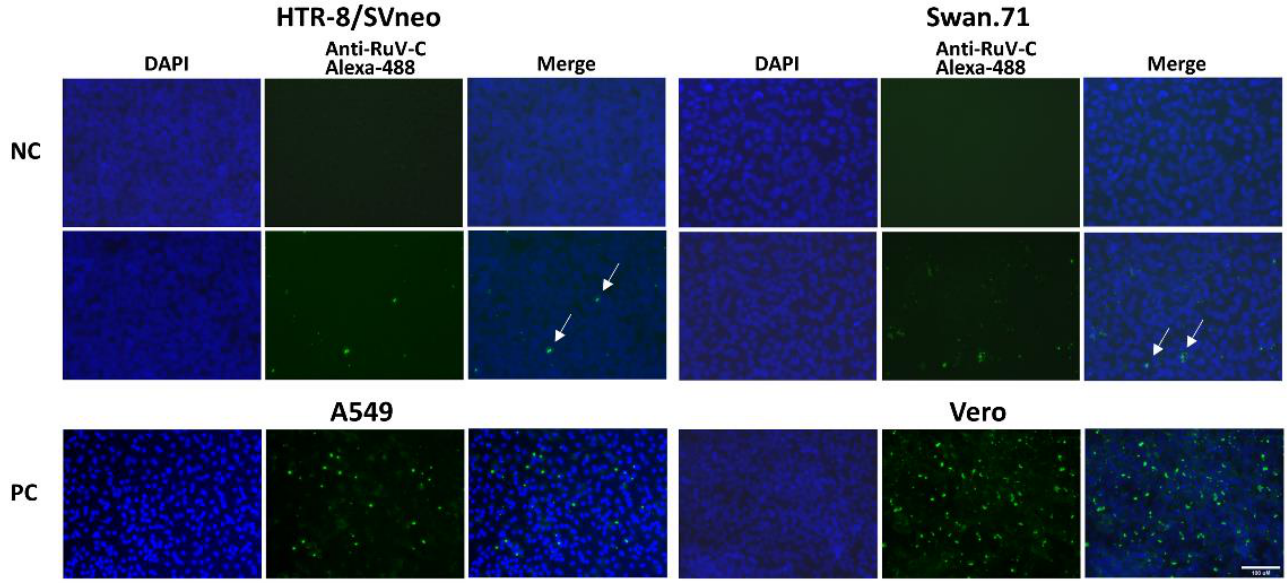
Figure 1. Microscopic images of the first-trimester trophoblast cells infected with RuV. The cells were fixed 48 hpi and labeled with mouse monoclonal anti-rubella viral capsid antibody, followed by Alexa 488-conjugated goat anti-mouse IgG (H + L) secondary antibody (green). Nuclei were stained with DAPI (blue). A549 and Vero cells were used as positive controls. Trophoblast cells that were mock-infected, incubated with heat-inactivated RuV, or stained with mouse serum were used as negative controls. Images are representative of 3 independent experiments. RuV-C, rubella virus capsid; NC, negative control using heat-inactivated RuV; PC, positive control. Scale bar: 100 μM. The infection with RuV in the studied trophoblast cells was confirmed by FCM anal- ysis. The percentages of RuV-infected trophoblast cells ranged from 2% to 7% (4–5%